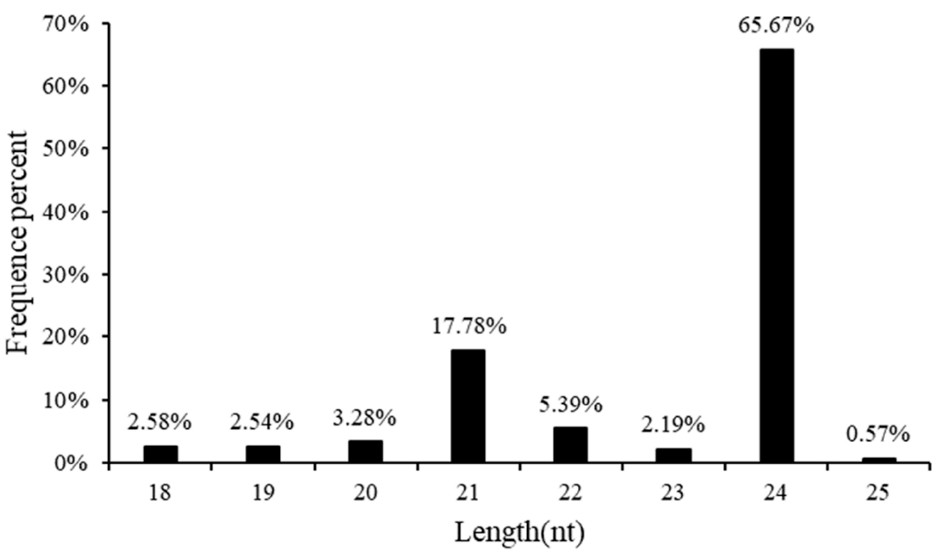
Figure 1. Length distribution and abundance of the sequences.